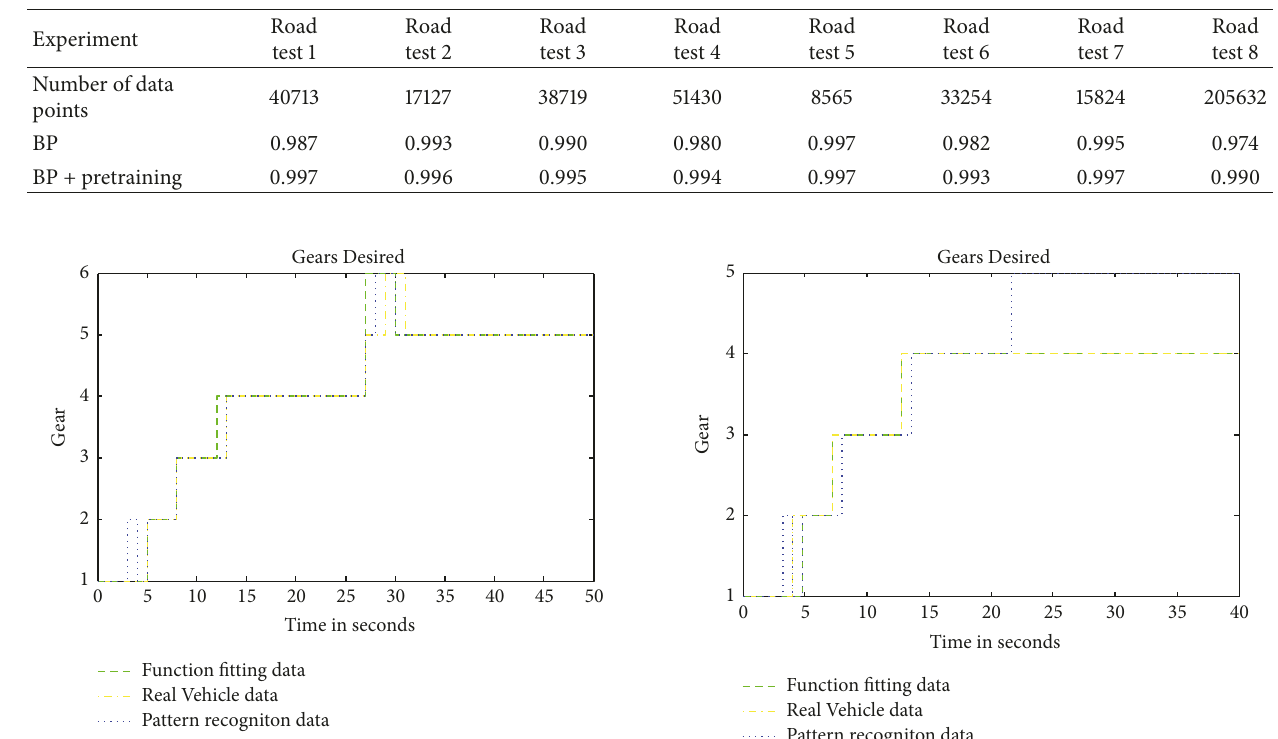
Table 2: Comparison of algorithms with and without pretraining.